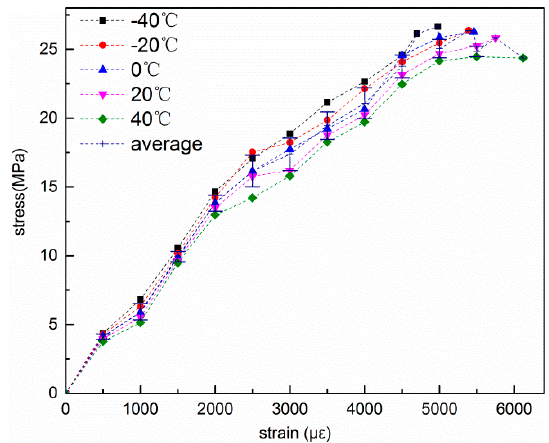
Figure 5. Bending tensile stress-strain curve.